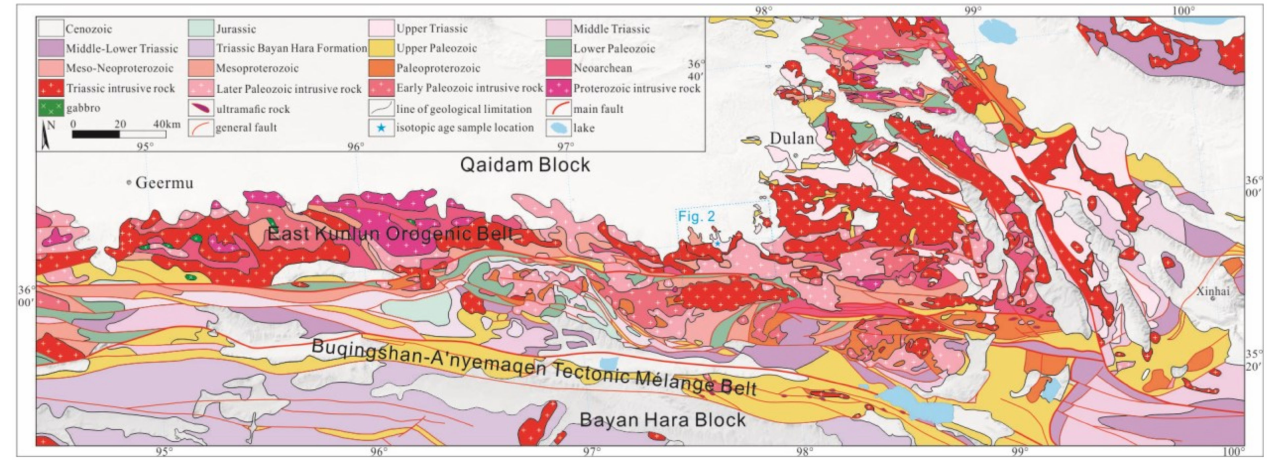
Figure 1. Map showing the regional context of the EKOB. Light blue rectangle outlines the area shown in Figure 2. Geological map modified from Li et al. [1]. Topographic map data: https://map.tianditu. gov.cn/ (accessed on 10 January